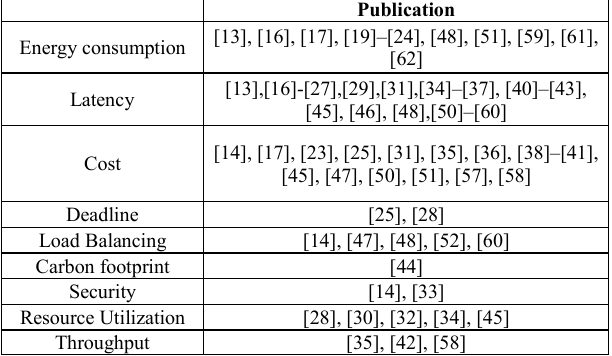
O BJECTIVES OF C OMPUTATION M